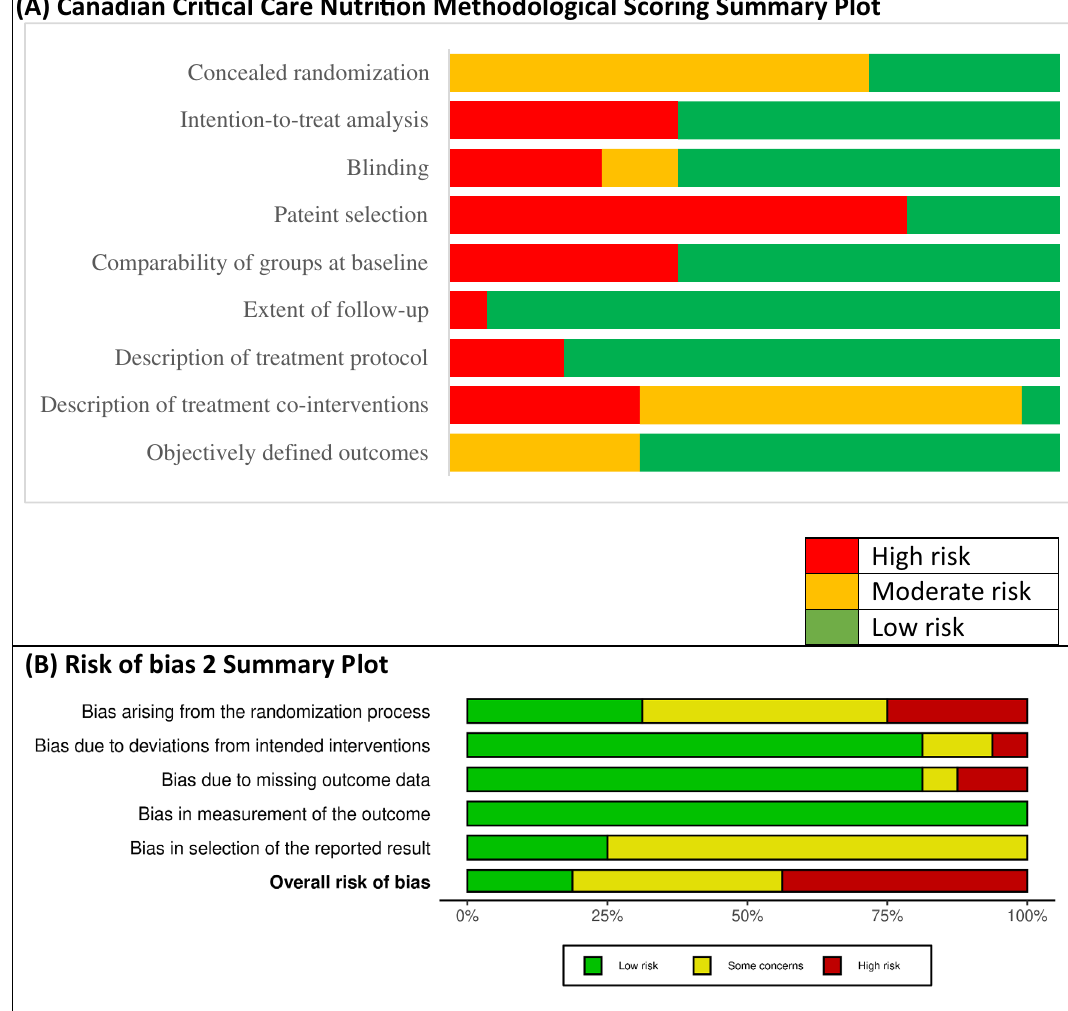
tional file 1: Figure S16). Additional file 1: Figure S22